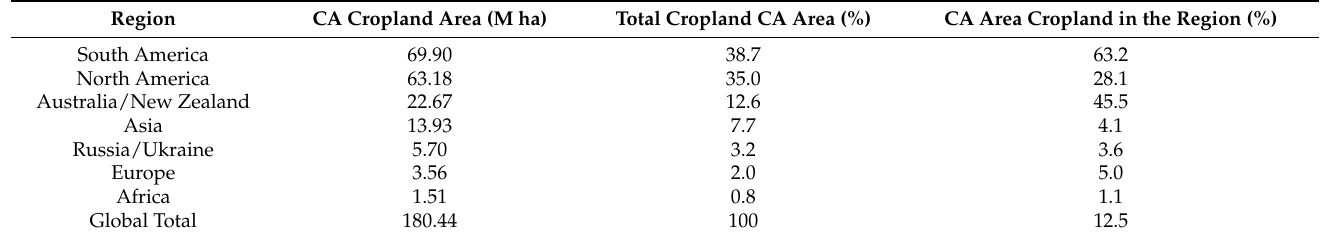
Table 2. Cropland areas employed for CA by region in 2015–16, CA area as percentage of global total cropland, and CA area as percentage of cropland of each region